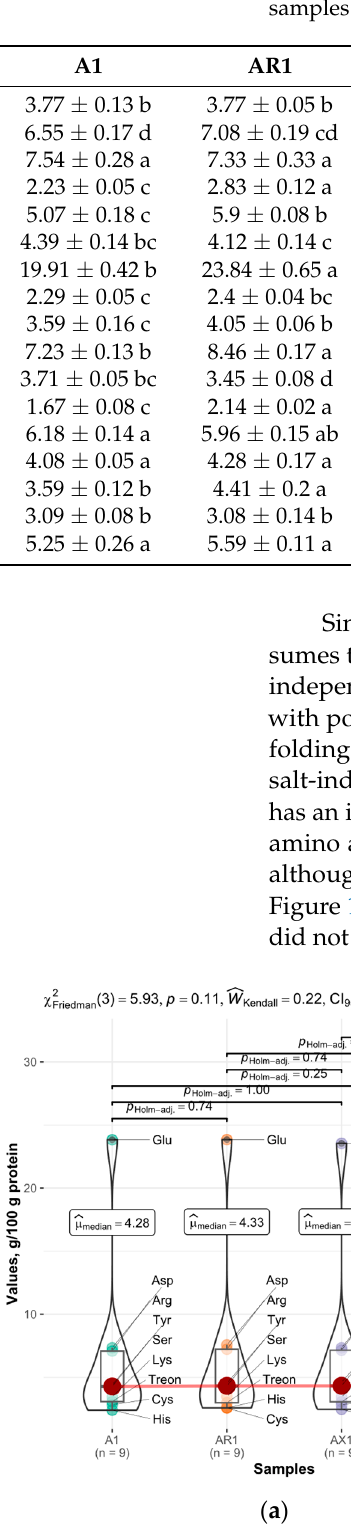
Figure 1. Amino acid redistribution in ( a ) polar and ( b ) non-polar groups among the samples A1, AR1, AX1, AXR1, values, mean, g/100 g protein. Processed data is plotted within the figures. In contrast to the similarity of AA profiles among the protein concentrates, the redis- tribution of AAs among the rolled oats and its derivatives obtained through the process, particularly the oat protein concentrates and oat fiber fractions, varied substantially and are discussed below.